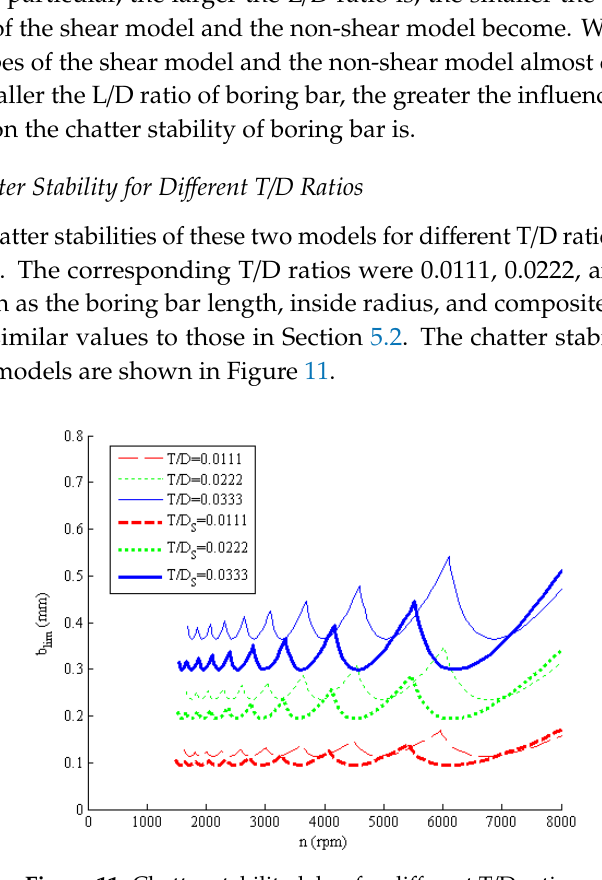
Figure 11. Chatter stability lobes for different T/D ratios.